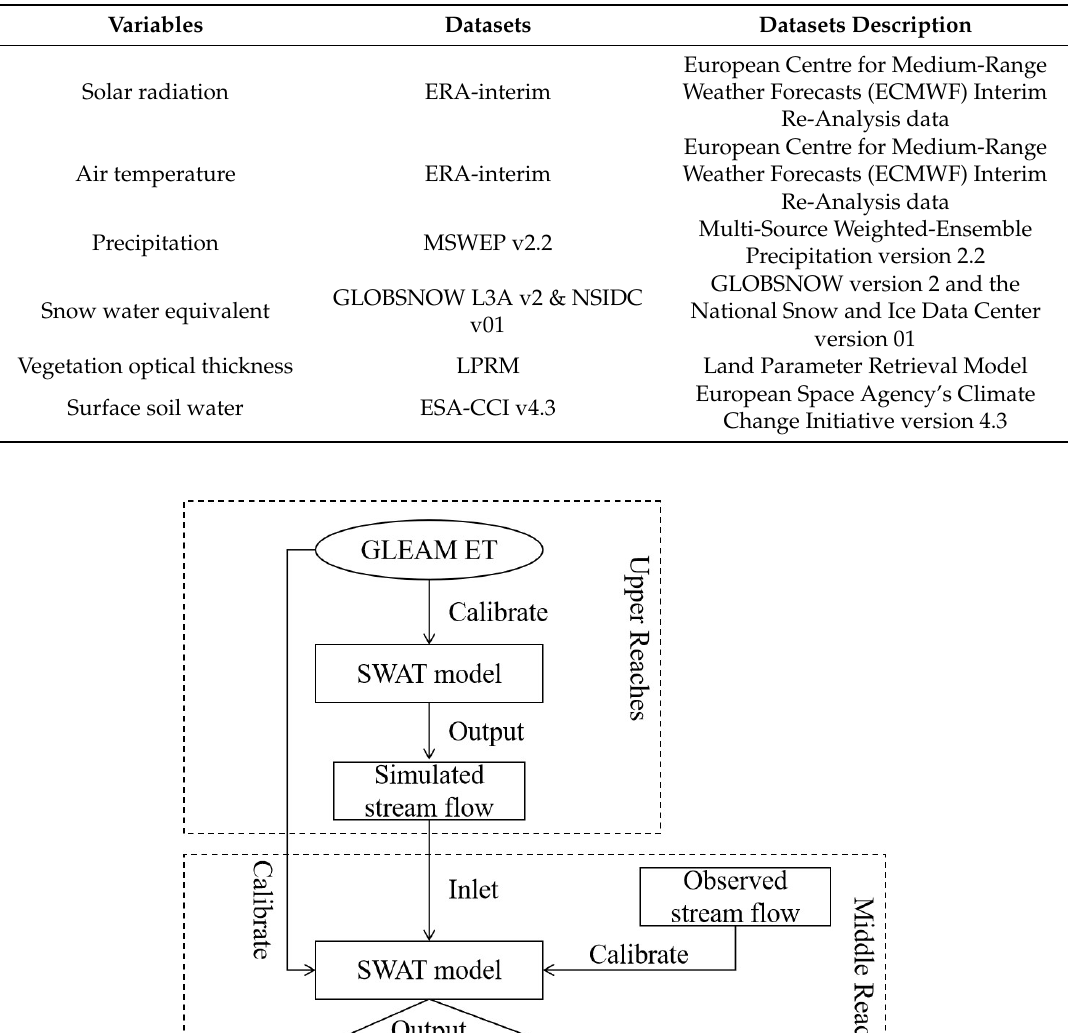
Table 1. Variables to calculate the actual evapotranspiration (ET) in the Global Land surface Evaporation Amsterdam Methodology (GLEAM).